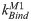
Distribution of the parameter kBindM1 in MGO 3 (blue rectangles) for the low impact (A), high impact (B), additive (C) and shift strategy (D).For the low and high impact strategy the distributions were assembled with five Gaussians (red curves). The position of the Gaussians were obtained as described in the corresponding subsections. For the additive and shift strategy, bootstrap parameter estimates (solid and dashed red curves) were used to generate the distribution of the MGO (blue rectangles). Distributions are normalized with respect to the total number of infected cells.